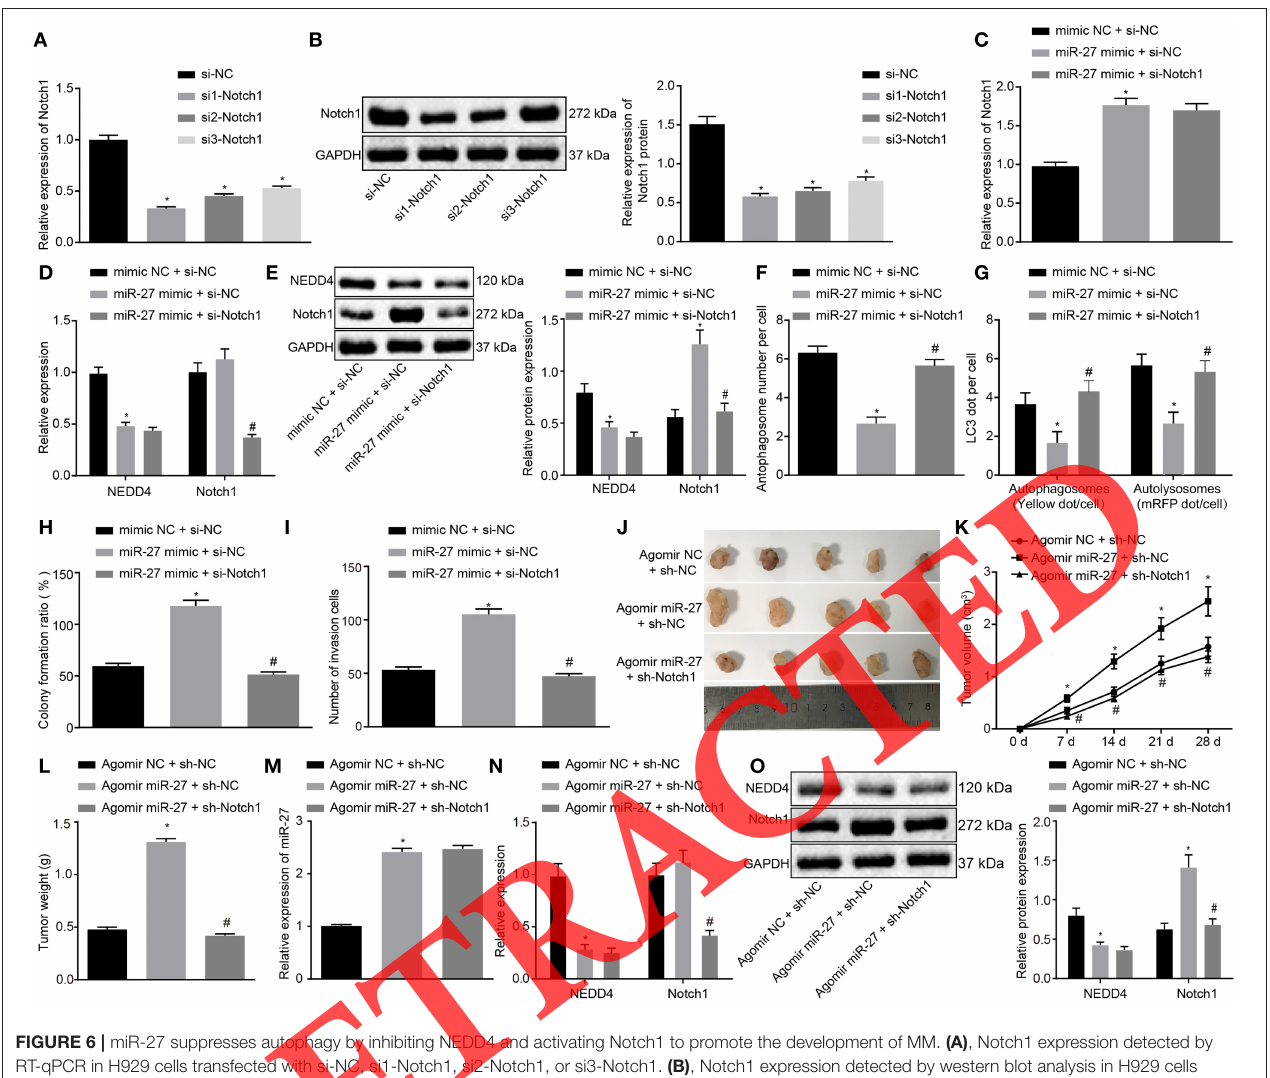
FIGURE 6 | miR-27 suppresses autophagy by inhibiting NEDD4 and activating Notch1 to promote the development of MM. (A) , Notch1 expression detected by RT-qPCR in H929 cells transfected with si-NC, si1-Notch1, si2-Notch1, or si3-Notch1. (B) , Notch1 expression detected by western blot analysis in H929 cells transfected with si-NC, si1-Notch1, si2-Notch1, and si3-Notch1. * p < 0.05 compared with H929 cells transfected with si-NC. H929 cells were transfected with mimic NC + si-NC, miR-27 mimic + si-NC, or miR-27 mimic + si-Notch1. (C) , miR-27 expression in H929 cells detected by RT-qPCR. (D) , NEDD4 and Notch1 mRNA expression in H929 cells detected by RT-qPCR (E) , NEDD4 and Notch1 protein expression in H929 cells detected by western blot analysis. (F) , The number of autophagosomes in H929 cells (bar = 1 µ m). (G) , Autophagic flow in H929 cells (bar = 25 µ m). (H) , H929 cell proliferation detected by colon formation assay. (I) , The invasion ability of H929 cells assessed by Transwell assay (bar = 50 µ m) * p < 0.05 compared with H929 cells transfected with mimic NC + si-NC, # p < 0.05 compared with H929 cells transfected with miR-27 mimic + si-NC. H929 cells transfected with Agomir NC + sh-NC, Agomir miR-27 + sh-NC, or Agomir miR-27 + sh-Notch1 were subcutaneously injected into nude mice. (J) , Tumor volume of nude mice measured every 7 weeks ( n = 12). (K) , The change in the trend of tumor size in mice within 4 weeks of inoculation of H929 cells ( n = 12). (L) , Tumor weight of nude mice after 4 weeks of inoculation of H929 cells ( n = 12). (M) , Expression of miR-27 in tumors detected by RT-qPCR. (N) , The expression of NEDD4 and Notch1 mRNA in the tumors detected by RT-qPCR. (O) , The expression of NEDD4 and Notch1 protein in the tumors detected by western blot analysis. * p < 0.05 compared with mice treated with Agomir NC + sh-NC, # p < 0.05 compared with mice treated with Agomir miR-27 + sh-NC. The data were measurement data and expressed as mean ± standard deviation. Repeated-measures ANOVA was used for comparison of the weight of tumors at different time points, and one-way ANOVA was used for comparison among multiple groups. The cell experiment was repeated three